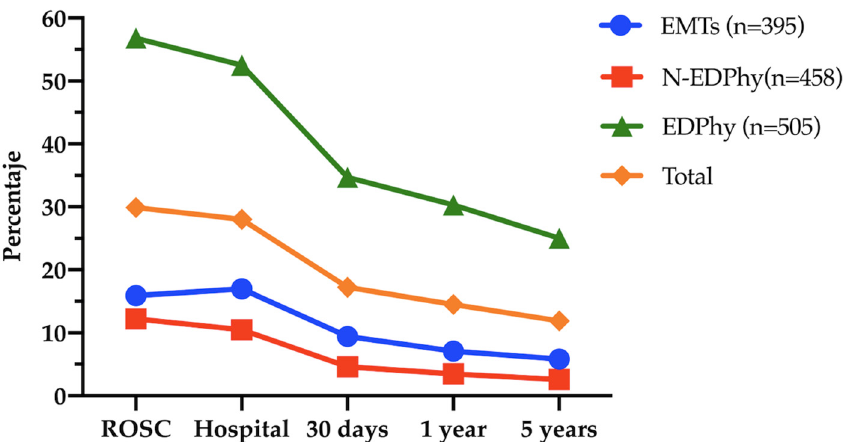
Figure 2. Survival percentage according to the type of medical emergency services. Note: EMTs: BLS emergency medical technicians; N-EDPhy: non-emergency dedicated physicians; EDPhy: emergency dedicated